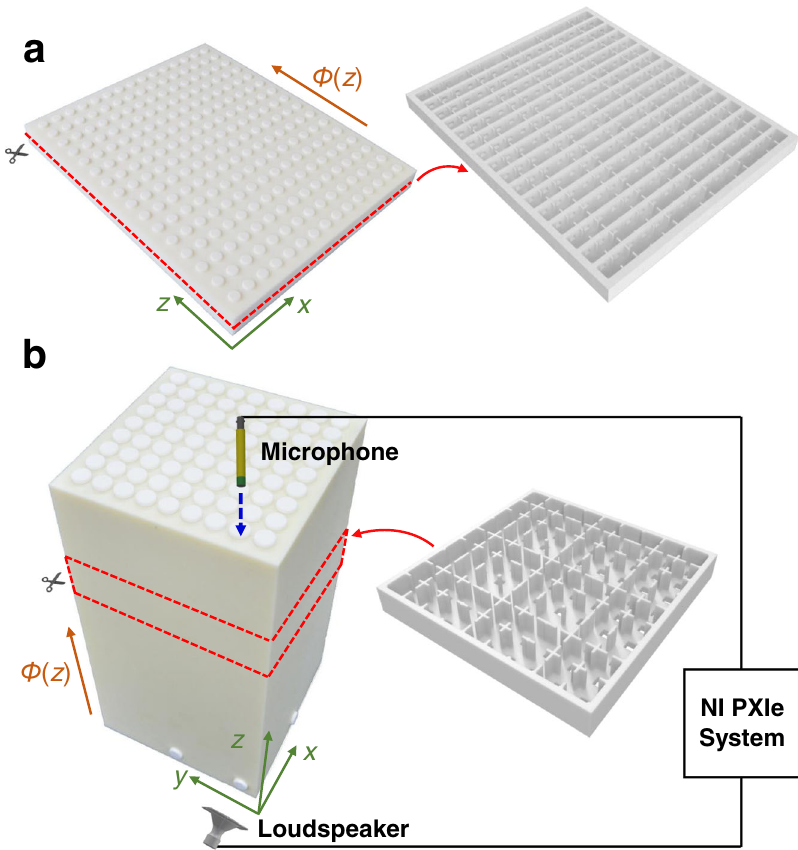
Fig. 6 Fabricated samples and experimental setup. a Photograph of the printed 2D channel-modulated sample. b Photograph of the printed 3D channel- modulated sample and schematic of the experimental setup. The microphone is inserted from the top of the sample to measure the sound pressure of each